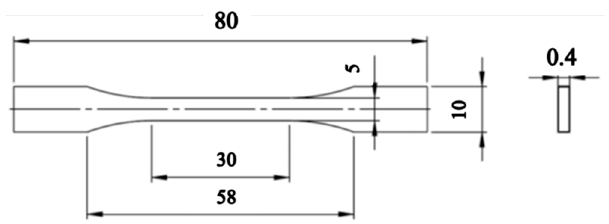
Figure A1. Geometry and Dimensions of the Samples Used for the Tensile Test Strength Measurements.